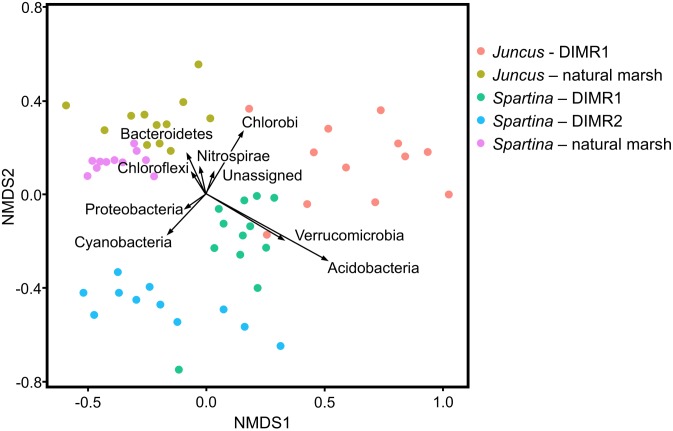
Two-dimensional non-metric multidimensional scaling (NMDS) plot with vectors displaying most abundant bacteria phyla identified in samples from S. alterniflora and J. roemerianus. The length of the vector is correlated to relative abundance of each of the dominant phyla. Samples are color-coded based on the plant species and sampling site. Controls are natural marsh samples.